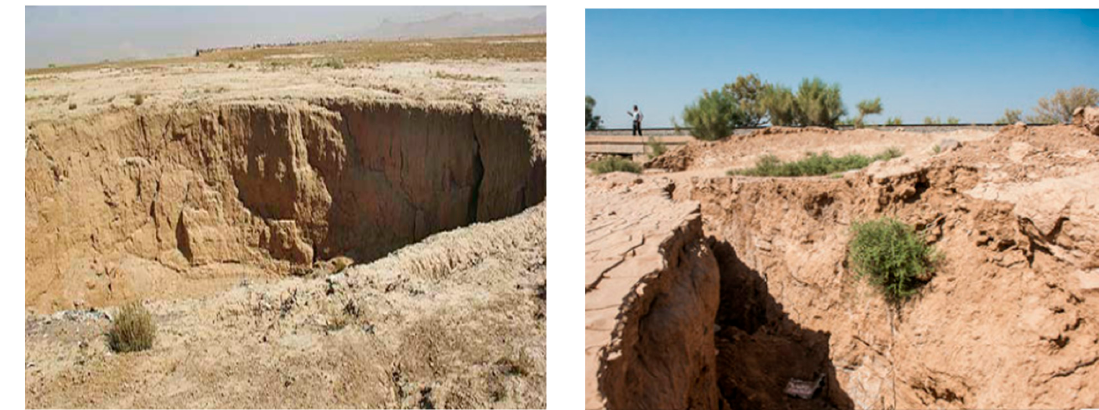
Figure 2. Examples of gully erosion in the study area.